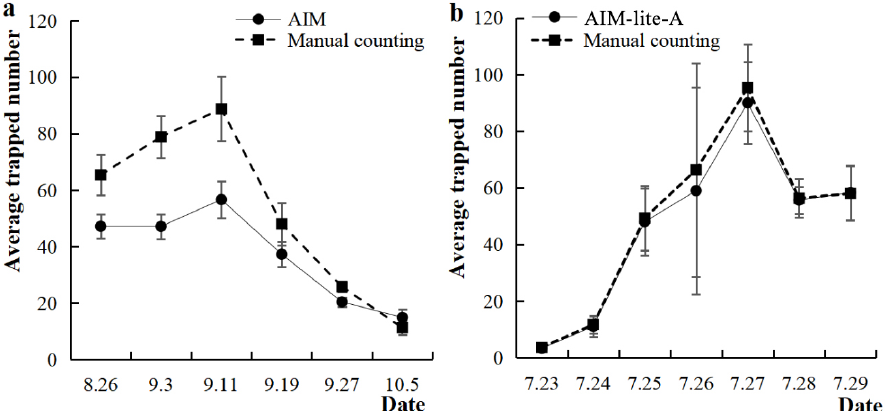
Figure 6. Automatic counting accuracy of two automatic insect monitors under different occurrence of S. litura. All data are mean ± SE. ( a ) Automatic counting accuracy of AIM in monitoring S. litura ; ( b ) Automatic counting accuracy of AIM-lite-A in monitoring S. litura .